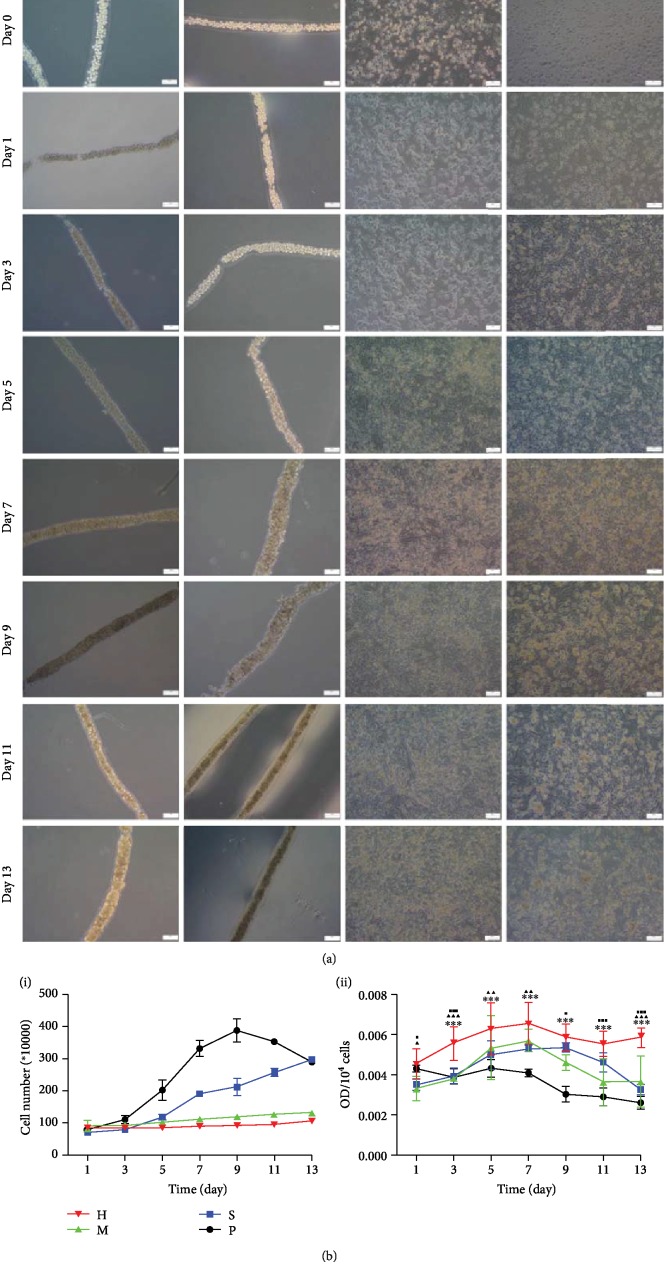
Morphological observations, cell growth curves, and hepatocyte viability. (a) Morphological observations in each group during liver tissue generation (all scale bars: 100 μm). (b) Cell growth curves and dynamic testing of hepatocyte viability: cell growth curves (i) and viability trends of the four groups (ii). The data are presented as the mean ± SD. Two-way ANOVA: H vs. P: ∗P < 0.05, ∗∗P < 0.01, ∗∗∗P < 0.001; H vs. S: ▲P < 0.05, ▲▲P < 0.01, ▲▲▲P < 0.001; H vs. M: ■P < 0.05, ■■P < 0.01, ■■■P < 0.001. H: hepatic plate-mimetic group; M: mixed 3D group; S: sandwich group; P: mixed 2D/plate group.